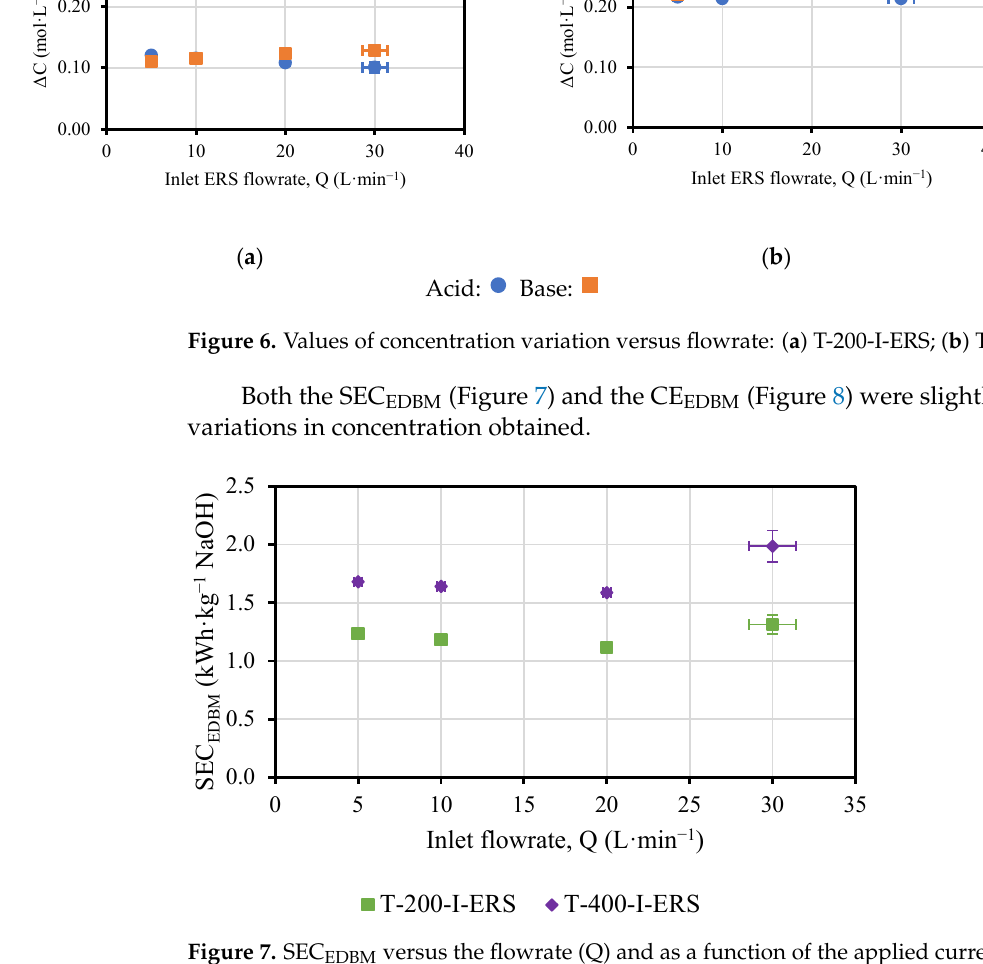
Figure 7. SEC EDBM versus the flowrate (Q) and as a function of the applied current density ( a ) T ‐ 200 ‐ I ‐ ERS; ( b ) T ‐ 400 ‐ I ‐ ERS.